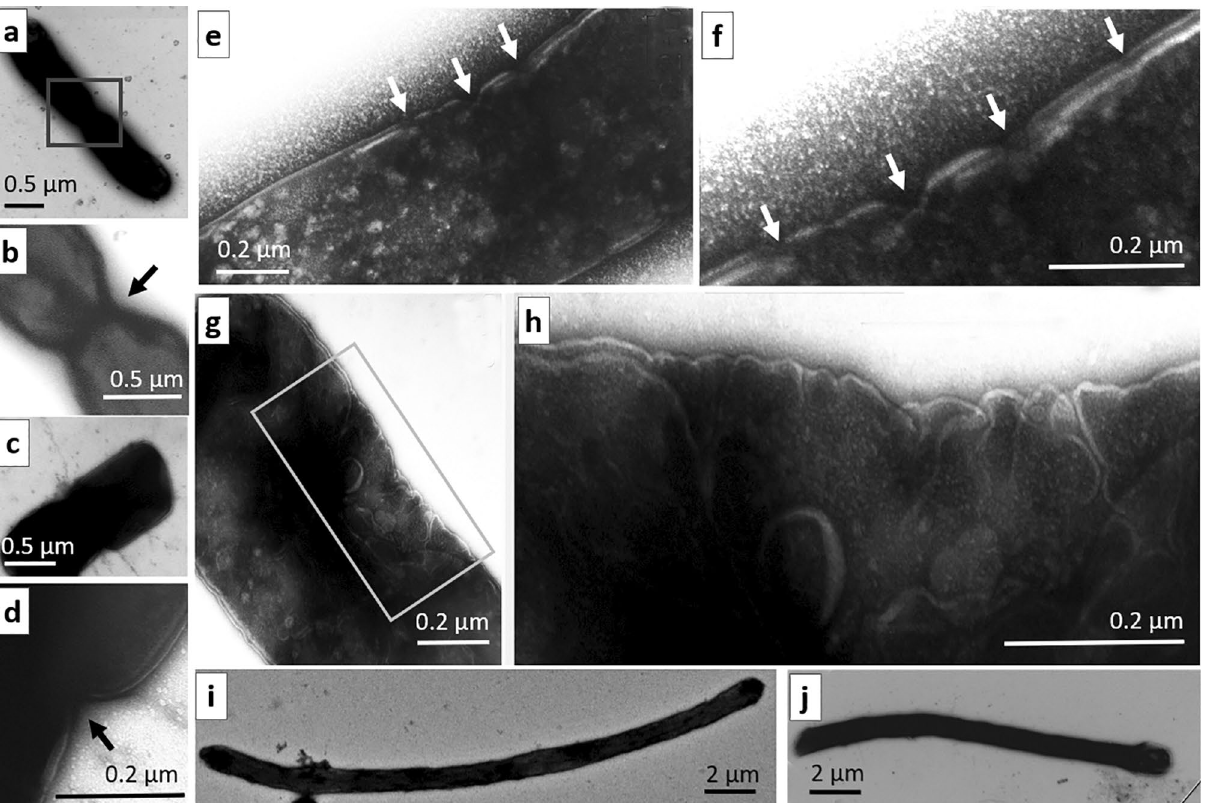
Figure 3. Disrupted structural organization of the envelope of dividing E. coli cells , as detected after exposure to THz radiation. ( a–d ) Examples of two dividing bacterial cells at low and high magnification with V-shaped invaginations in the envelope (indicated by arrows) in control. ( e,f ) Multiple V-shaped invaginations and breaches in the envelope of irradiated bacteria at low and high magnification (indicated by arrows). ( g,h ) Asymmetric unilateral formation of numerous folds in the envelope in the central part of an irradiated cell. The scale bar is 0.5 μm in ( a–c ); 0.2 μm in ( d–h ); and 2 μm in ( i,j